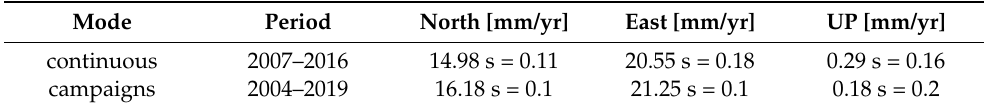
Figure 8. Position residuals for the site 1285 on top of Mt. Wank between August 2007 and Mai 2016. Offsets caused by equipment change, seasonal periodic variations and the trend, usually caused by plate tectonics, have been removed. Table 6. Velocities of the GNSS site 1285 based on two different approaches. The accuracy estimates for the “continuous” approach are based on the analysis with program HECTOR. The standard deviations s for the “campaign” approach are crude estimates derived by scaling the internal error estimates by a factor of 10 which ensures to have more realistic